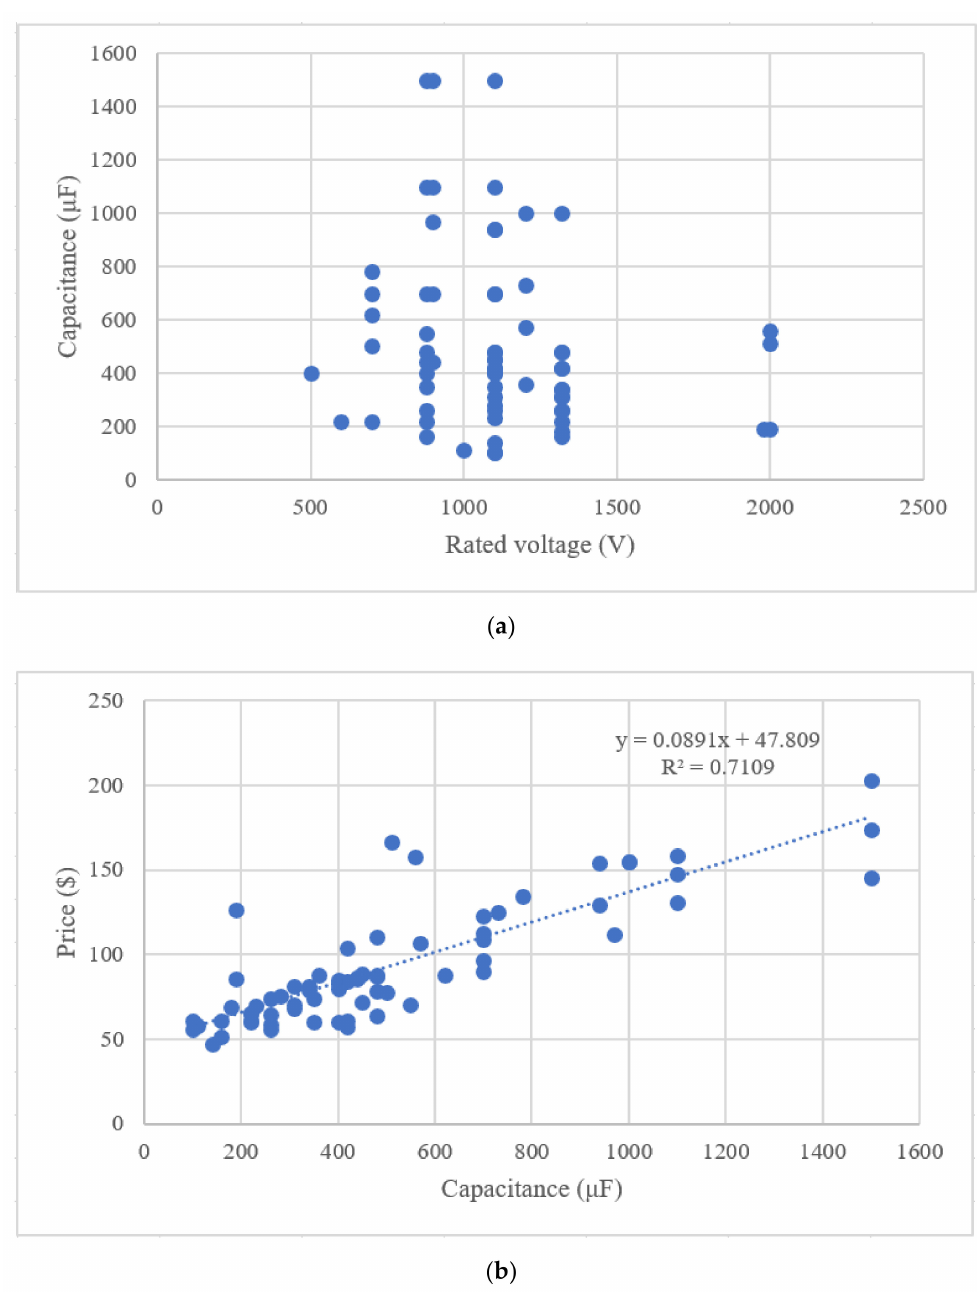
Figure 14. Price distribution and cost model of capacitor: ( a ) Price distribution of metalized film capacitors on the market; ( b ) cost model of the